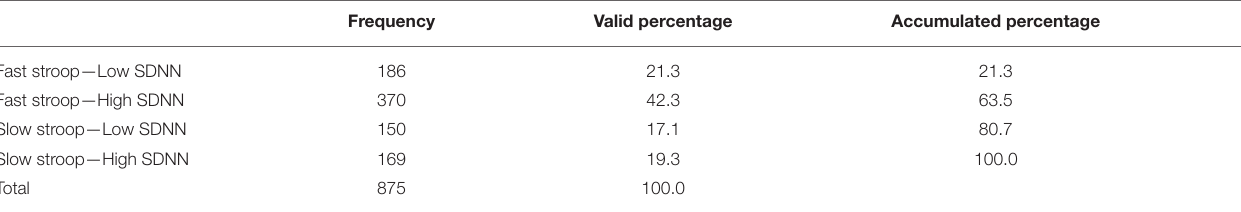
TABLE 2 | Summary of descriptive data of SDNN-Stroop